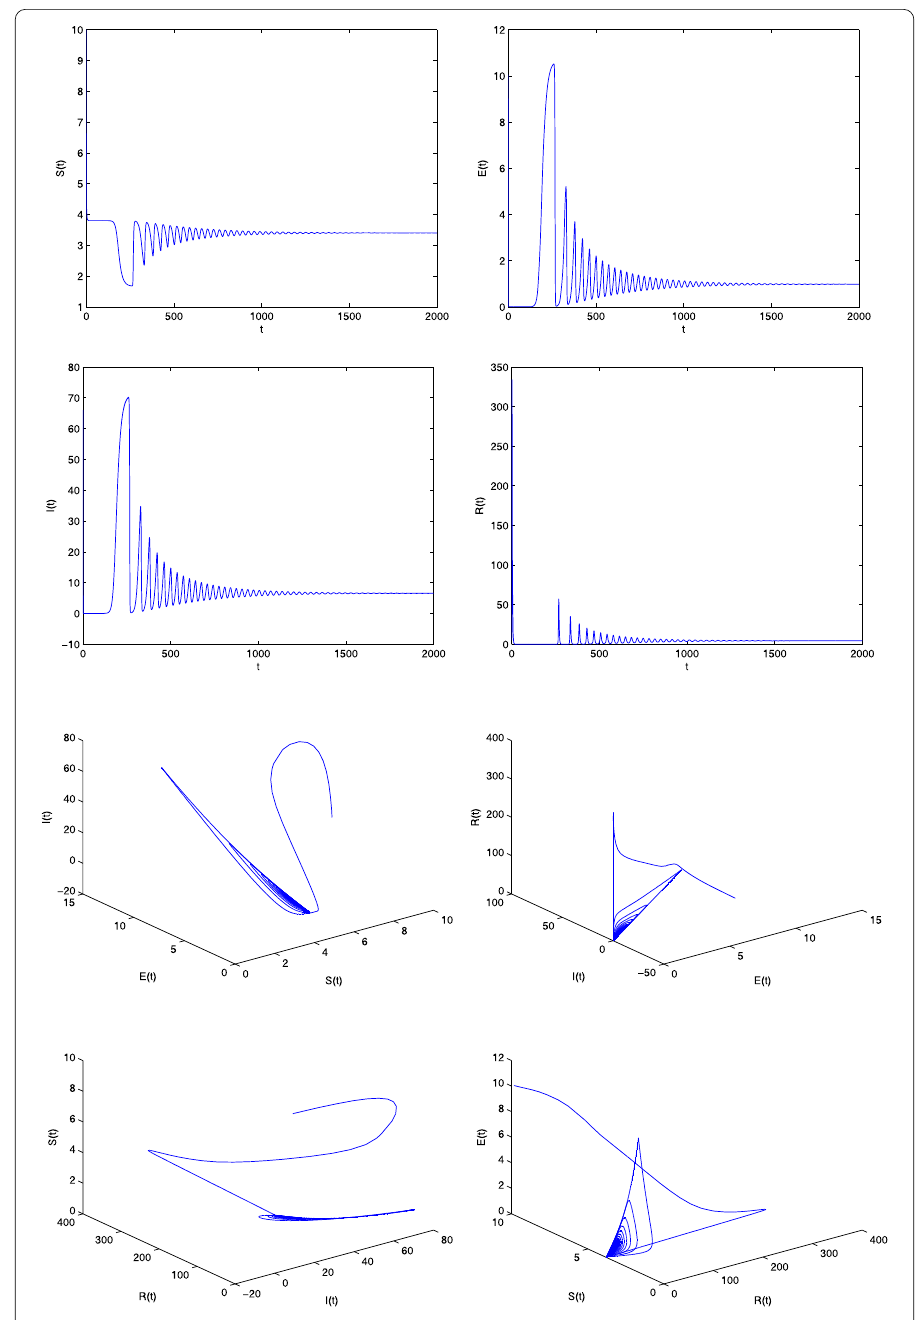
Figure 1 The phase diagrams of the system (2) is asymptotically stable when τ = 0.9